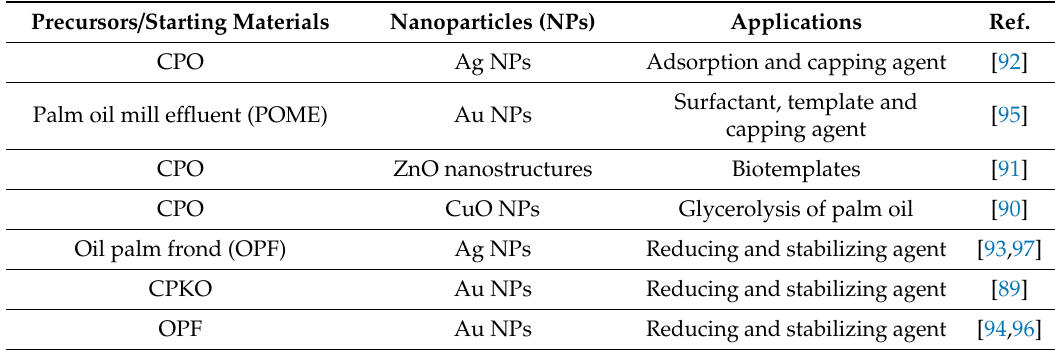
Table 2. Oil palm-based material helps in facilitating biosynthesis of